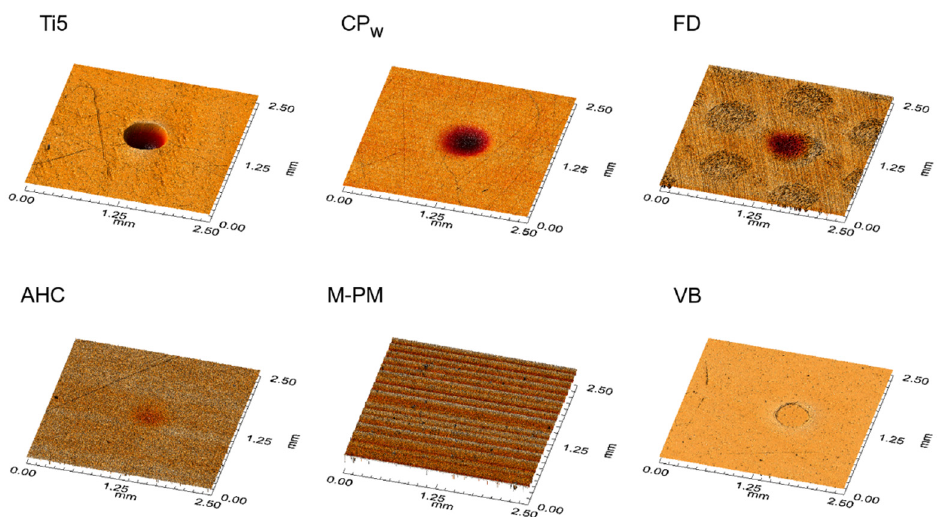
Figure 6. Representative surface topography images of HLD indentation areas. Indentations represent different permanent plastic material deformation of CRMs. Note greyish circular structures for FD, which represent glass fiber bundles of the composite material. Table 2. Characteristics of Leeb indentations.